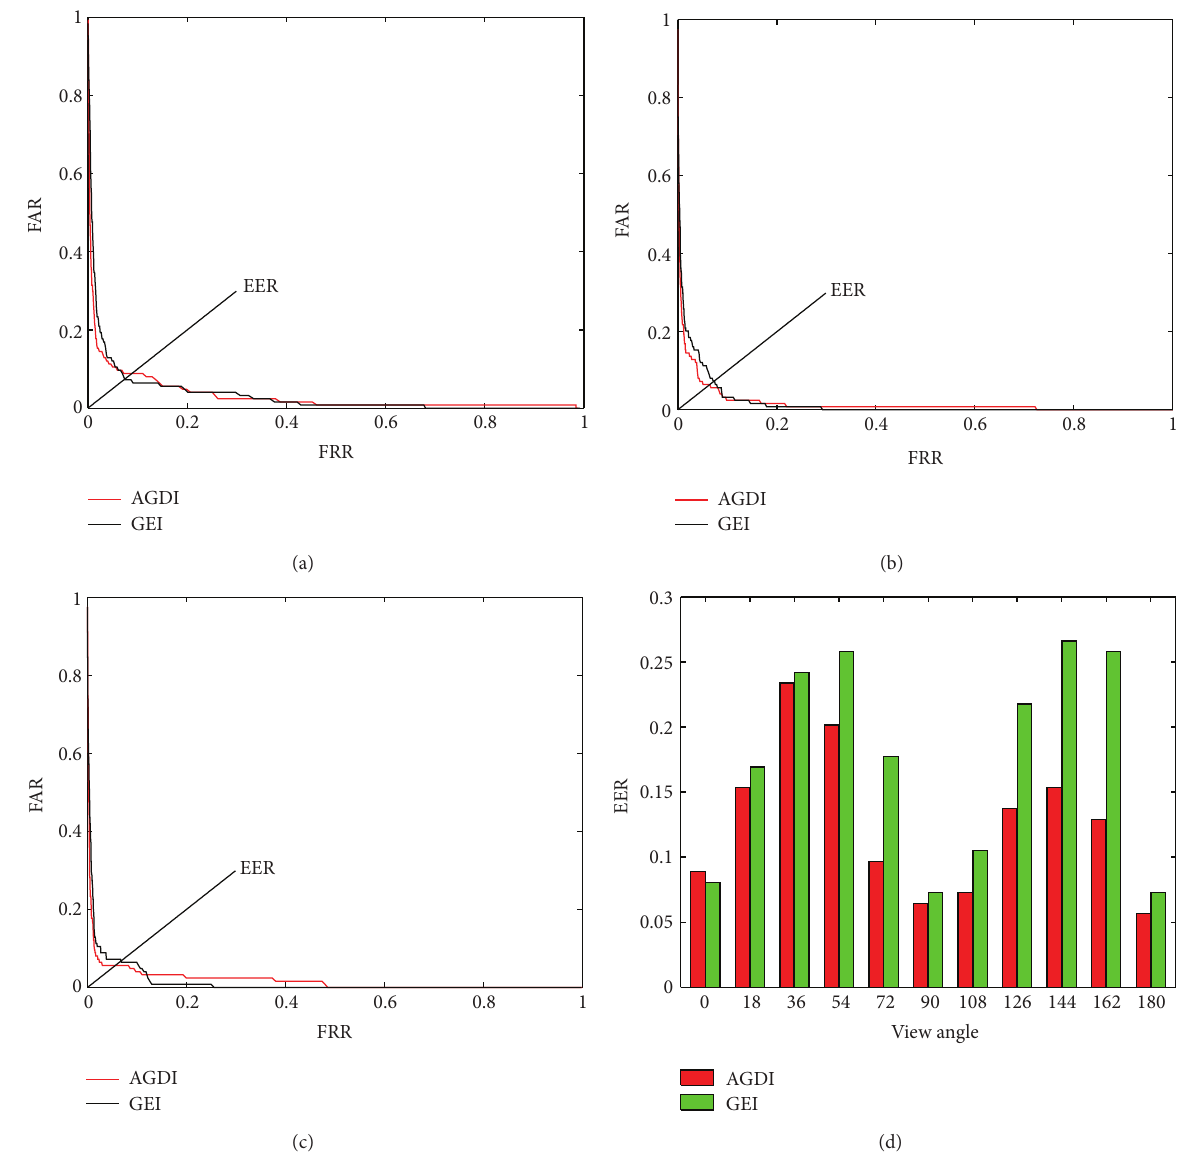
Figure 5: (a)–(c) The comparison of ROC curves of AGDI and GEI with view angles 0 ∘ , 90 ∘ , and 180 ∘ , respectively. (d) The comparison of EERs of AGDI and GEI with view angles 0 ∘ –180 ∘ . Table 2: Comparison of CPU time (ms) for PCA and 2DPCA feature extraction (CPU: Intel Core i3 2.30 GHz; RAM: 4 GB). Feature extraction